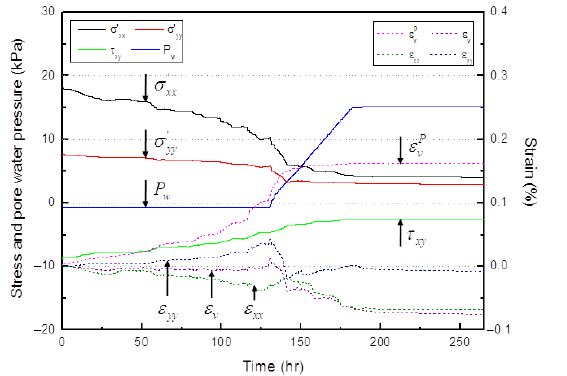
Fig. 17. Time histories of stresses, strains and pore water pressure (Case 1, at Element